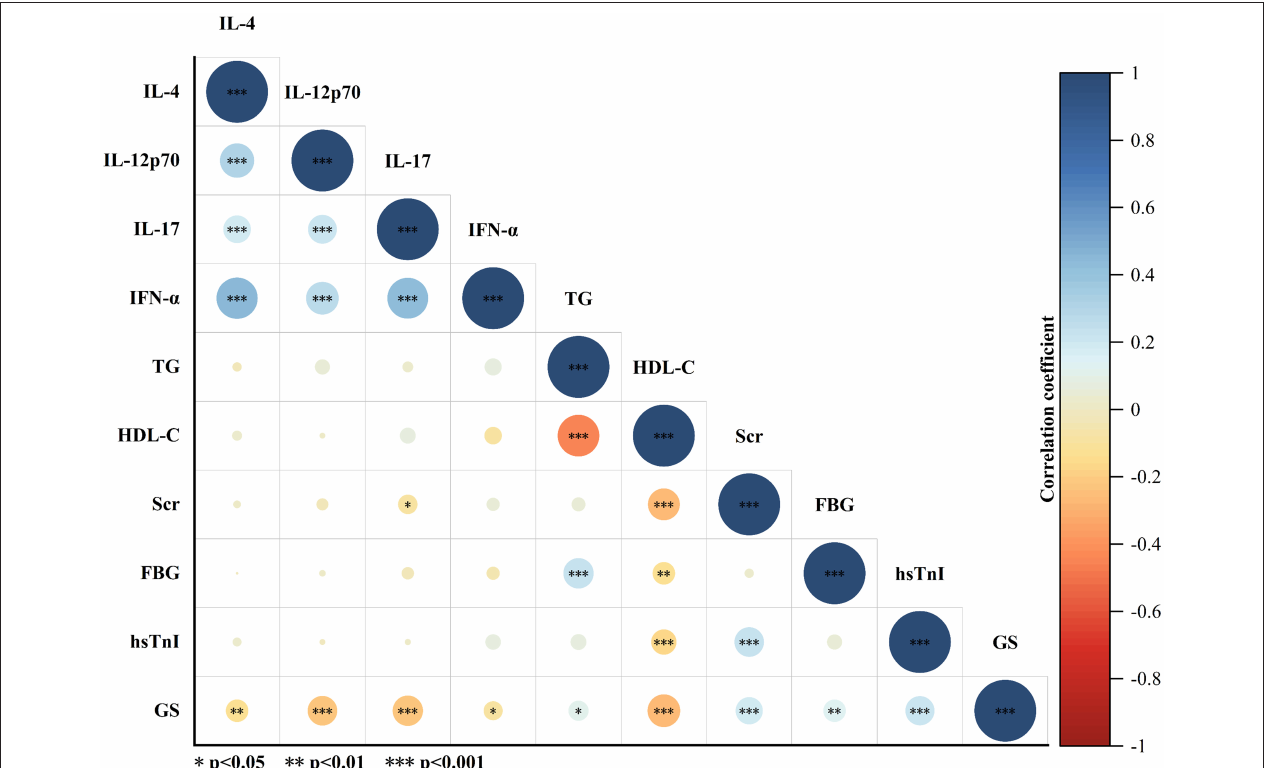
FIGURE 2 | Pearson correlation analysis of variables with statistically significant difference between non-severe CAD group and severe CAD group. The area and color of the circle represent the value of the correlation coefficient. The larger the area of the circle, the larger the absolute value of the correlation coefficient; the color of the circle corresponds to the value of the correlation coefficient on the color scale. * P < 0.05, ** P < 0.01, *** P <